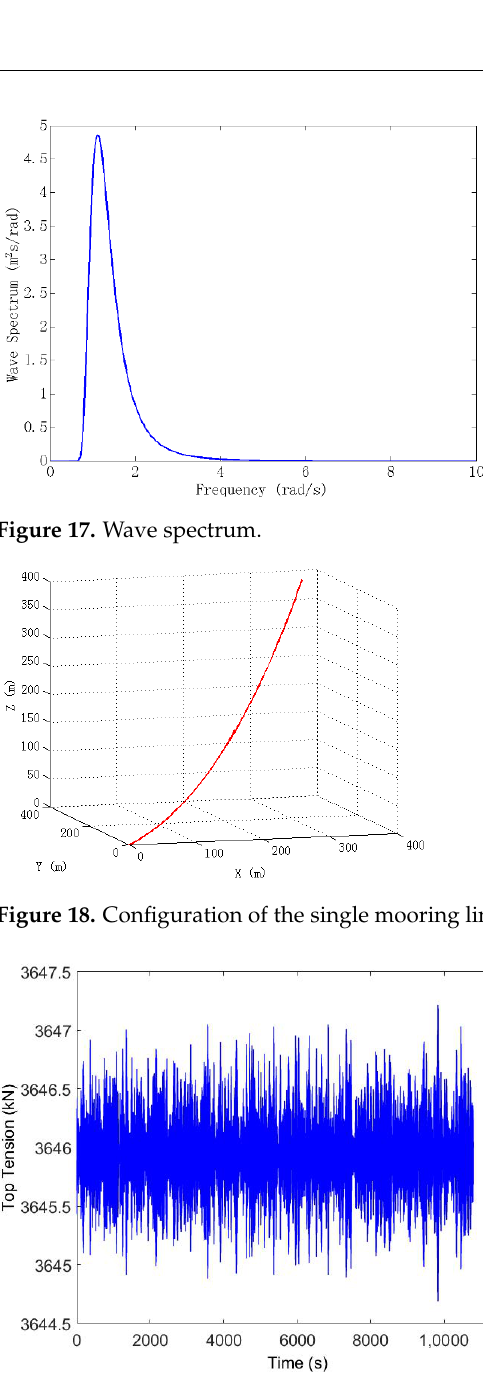
Figure 19. Spectral density of top tension single mooring line.